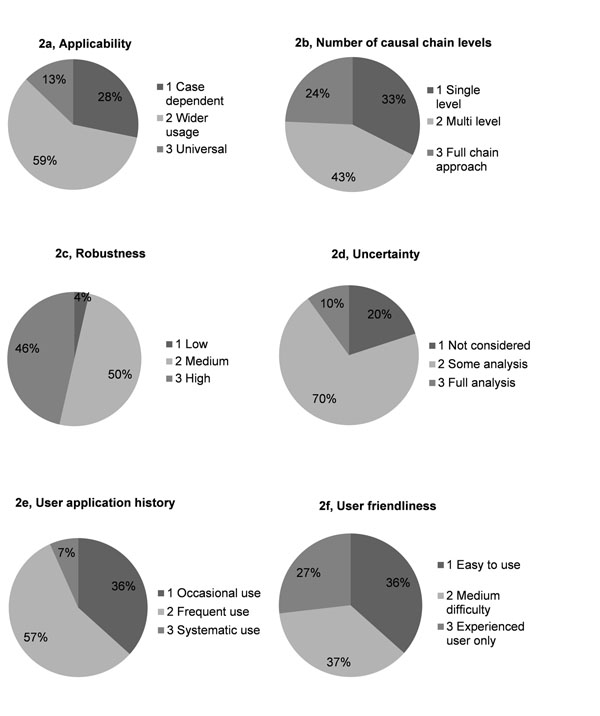
Evaluation of DSTs.